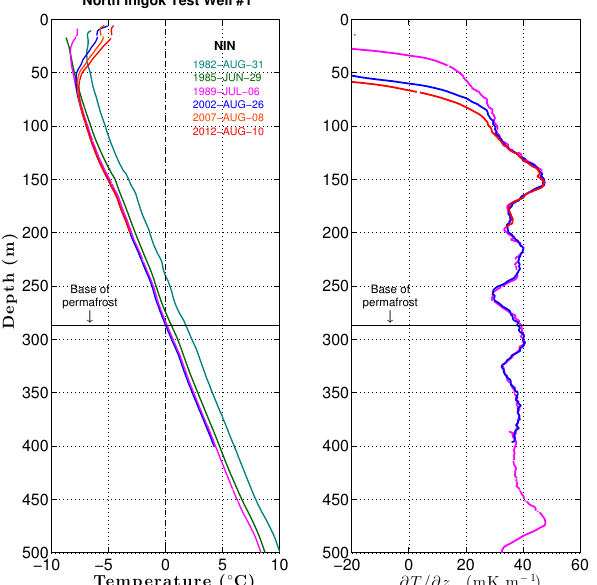
Earth Syst. Sci. Data www.earth-syst-sci-data.net